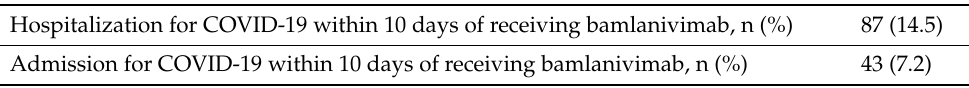
Table 4. Patient results (n =